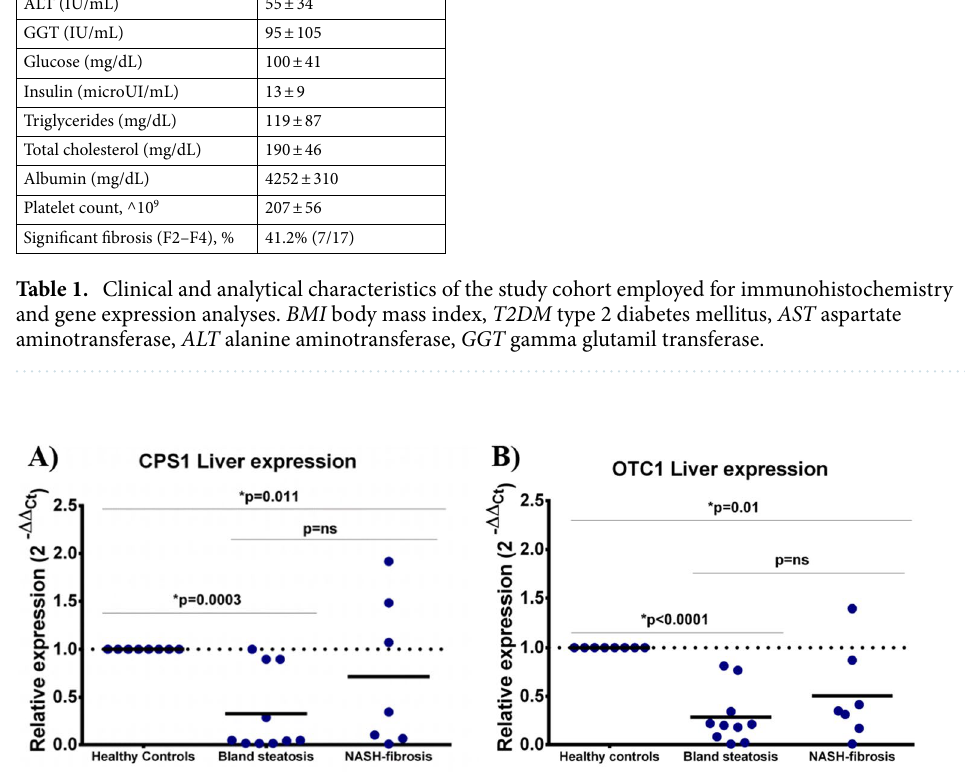
Figure 1. Relative expression results from CPS1 ( A ) and OTC1 ( B ) in liver biopsies from healthy controls, bland steatosis and NASH-fibrosis patients. CPS1: carbamoyl phosphate synthetase-1; OTC1: ornithine